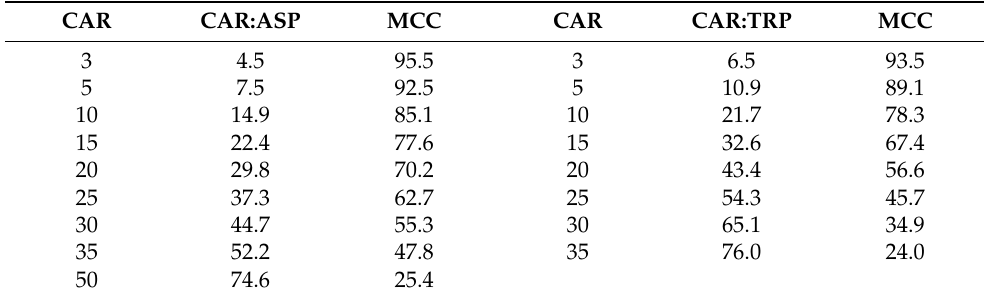
Table 1. Compositions (%, w / w ) of tablet formulations of co-amorphous CAR:amino acid and MCC blend with corresponding CAR percentages. CAR